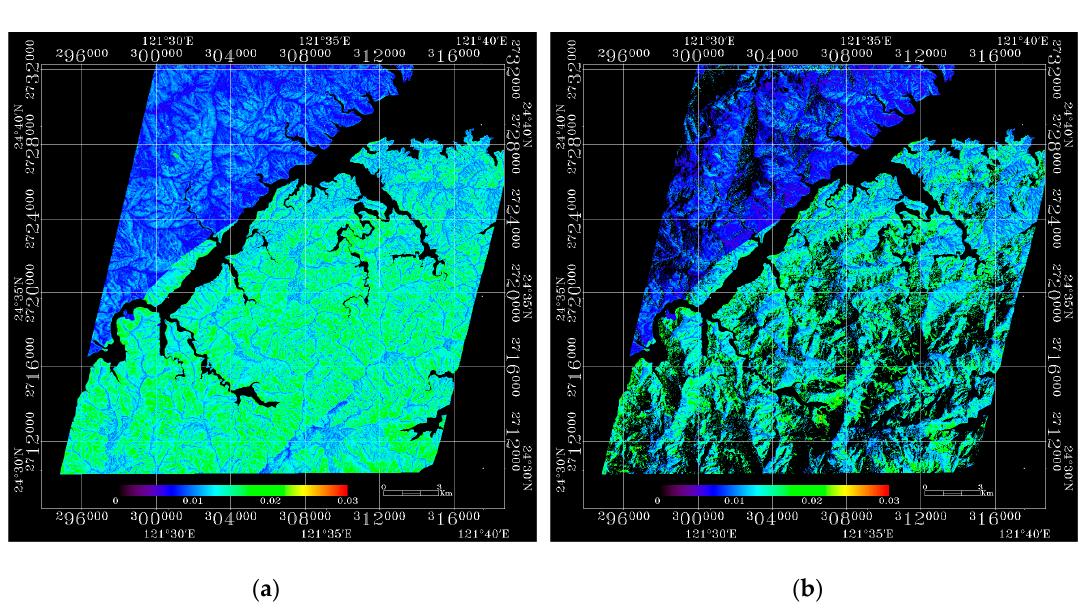
Figure 6. Maps of ( a ) LSI (without the correction for shadows) and ( b ) LSI* (with the correction for shadows) for all cells using Equations (5) and (8), respectively. Table 1. Quantitative assessment of the influences of shadows on the LSM.